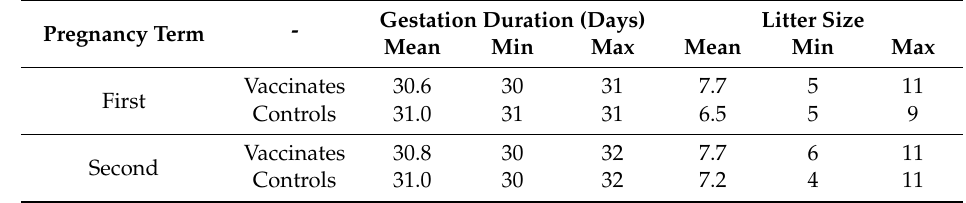
Table 4. Average body temperature ( ◦ C) in the second term of pregnancy in rabbits per day. Treatment Group Vaccinates Controls